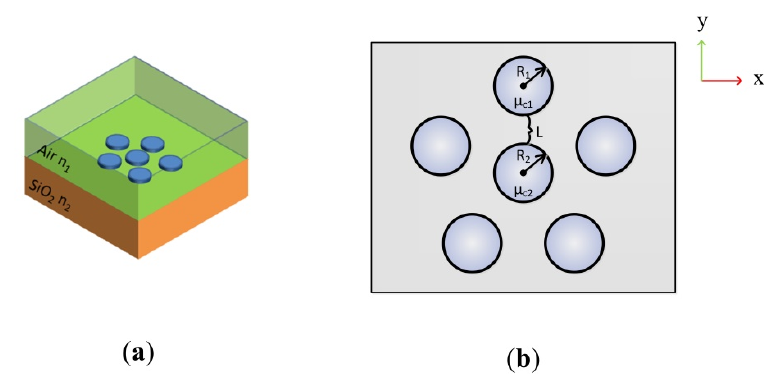
Figure 1. The abridged general view of the graphene hexamer. ( a ) The graphene hexamer lies on the silica substrate with n 2 = 1.5 and is surrounded by air with n 1 = 1; ( b ) The specific parameters of the graphene hexamer.